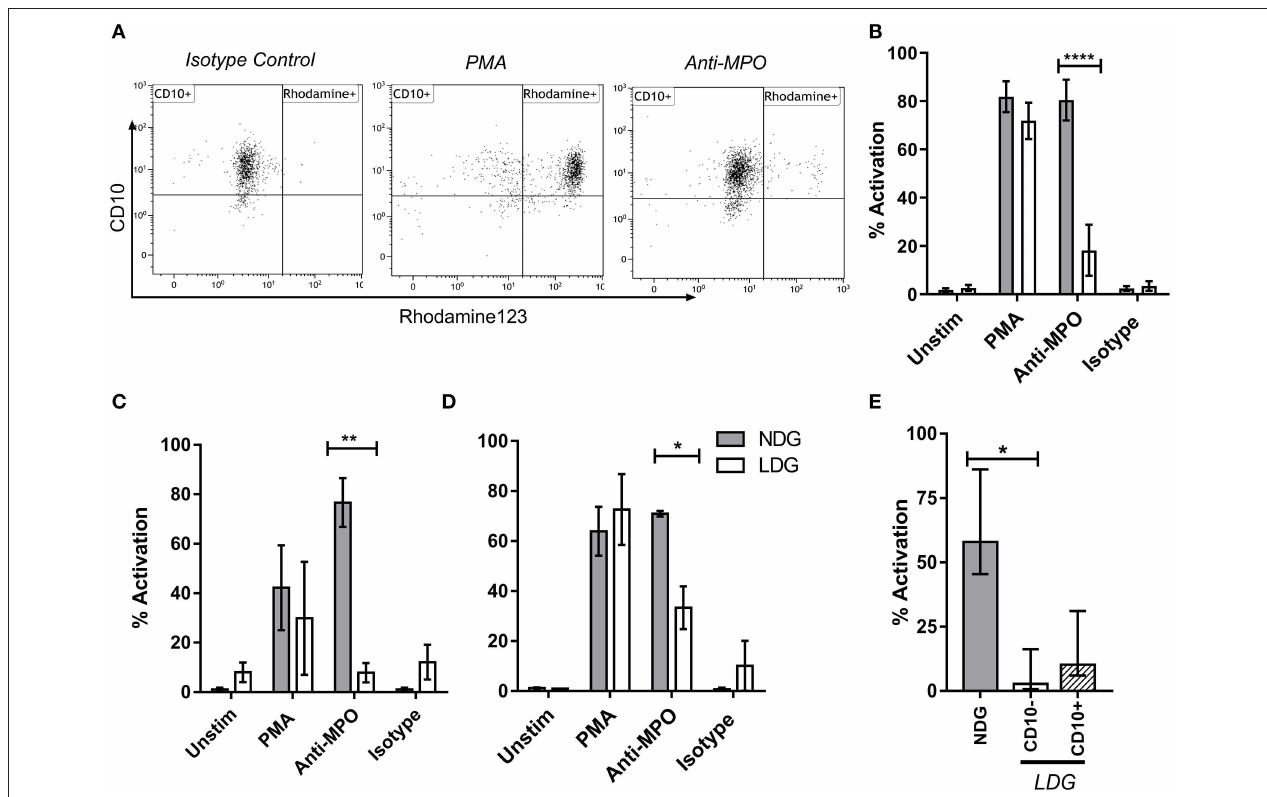
FIGURE 6 | LDG stimulated with anti-MPO display decreased ROS production compared to NDG. LDG and NDG samples were stimulated with isotype control, anti-MPO antibodies, and with PMA, after loading with DHR123. ROS production was quantified as the % of Rhodamine123 + cells. Representative dot plots are shown demonstrating the % rhodamine123 + LDGs from a patient with active AAV following exposure to isotype control, PMA and anti-MPO (A) . ROS production by LDGs and NDGs from Acute AAV patients (B) , healthy controls (C), and umbilical cord blood (D) , treated with DHR123 alone (unstim), or with DHR123 plus PMA, anti-MPO, or isotype control is shown. As ROS production was reduced in LDGs following anti-MPO stimulation, we tested whether this effect was restricted to the CD10 − subset (E) , Friedman test with Dunn’s multiple comparison test, n = 5. Differences between LDG and NDG response to stimulus were analyzed using 2-way ANOVA with Sidak’s multiple comparison test, n = 3 healthy control ; n = 5 Acute AAV, n = 2 Cord blood * p < 0.05, ** p < 0.01, **** p <